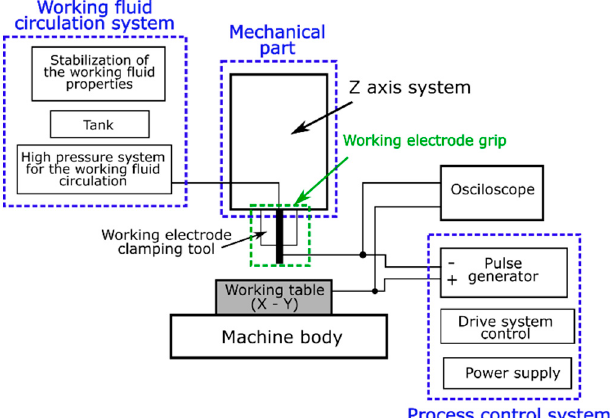
Figure 3. Scheme of the test stand and its main functional units. Table 3. Machining parameters.